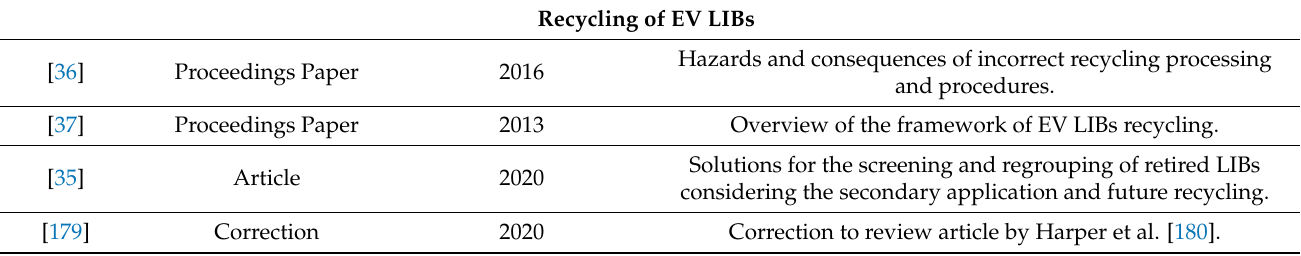
Table A7. Assessed literature in review for “Recycling of EV LIBs” category.